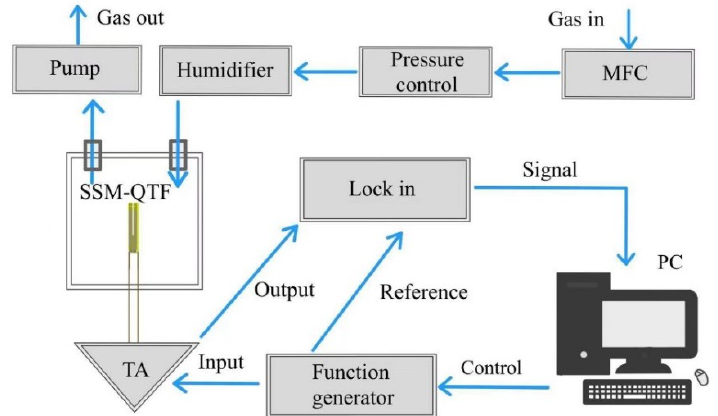
Figure 2. Experimental setup for humidity sensing. SSM-QTF: spider silk-modified QTF; TA: tran- simpedance amplifier; PC: personal computer; Lock-in: lock-in amplifier, MFC: mass flow control- ler.